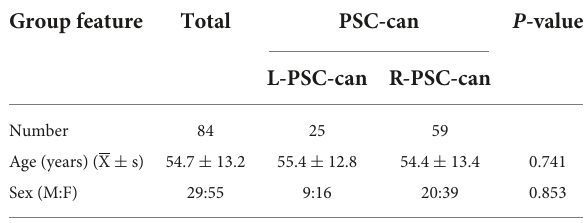
TABLE 1 Demographic features of subjects in the patients with